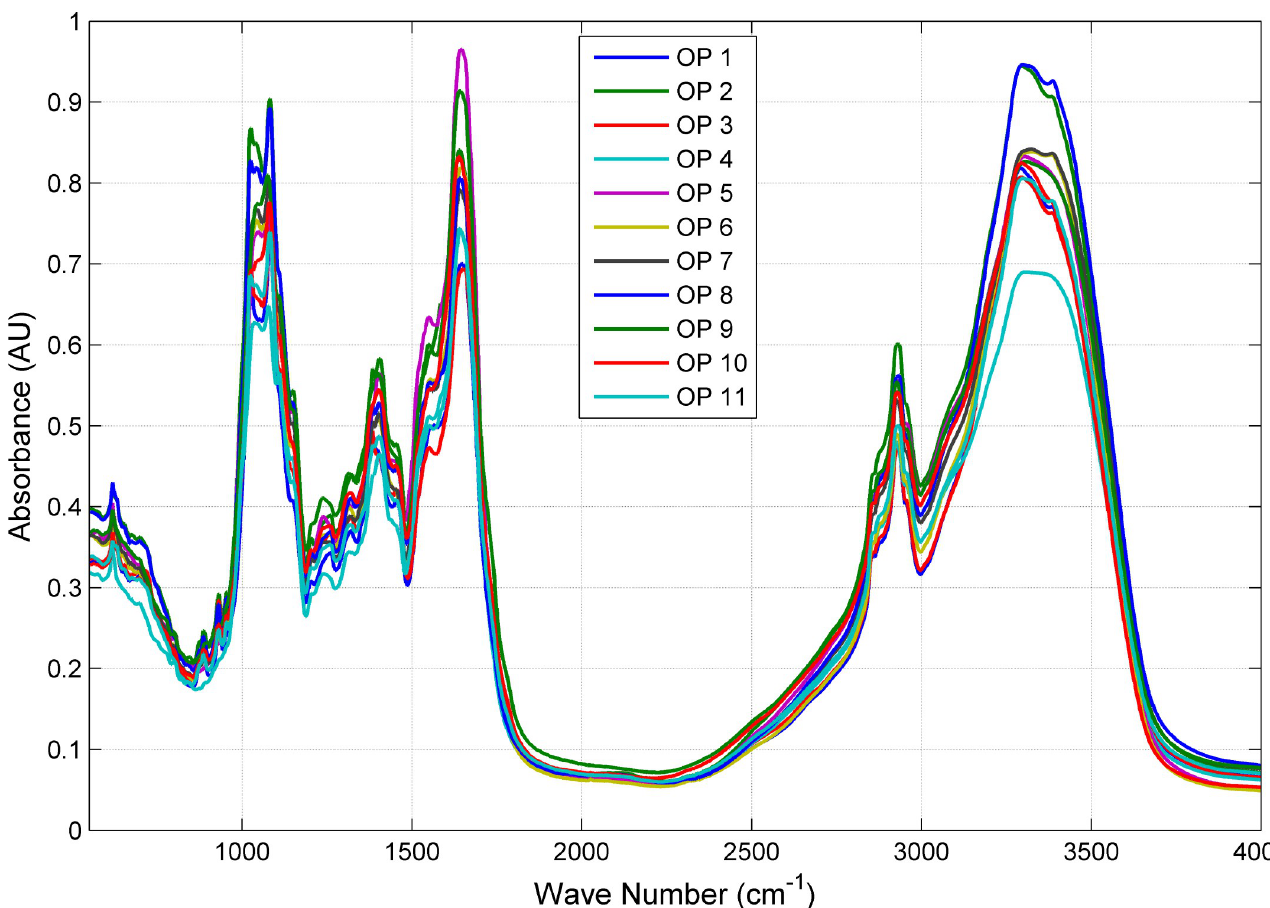
Fig 3. The average mid-infrared spectra of Cornus officinalis samples by different places of origin.